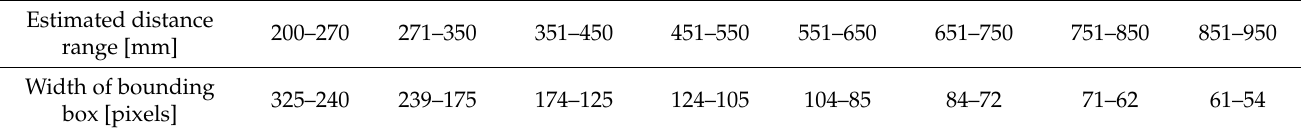
Table 5. Proposed lookup table for experimental data.